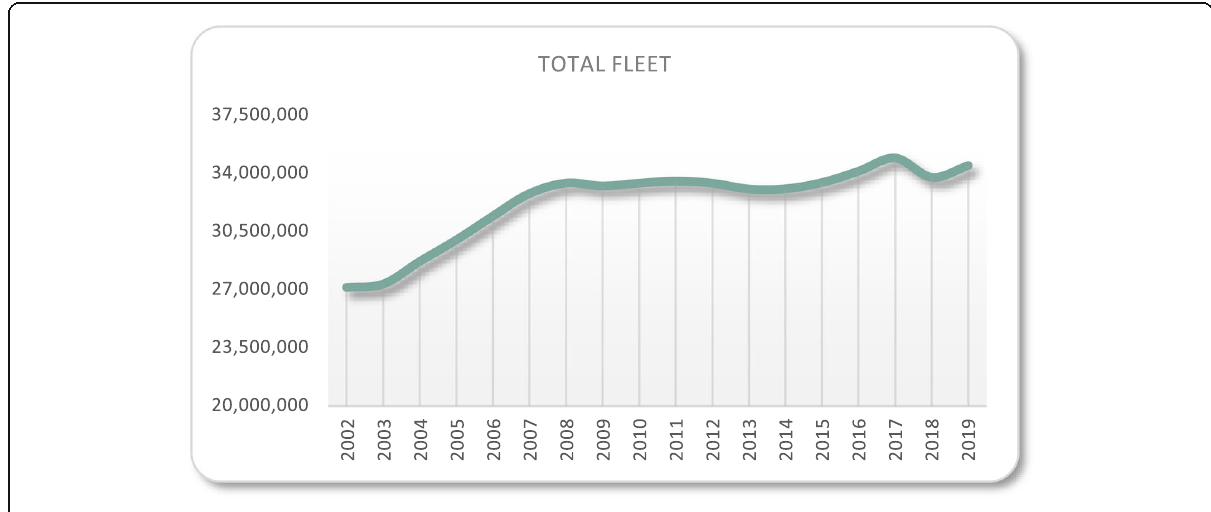
Fig. 4 The total vehicle fleet in Spain (2019